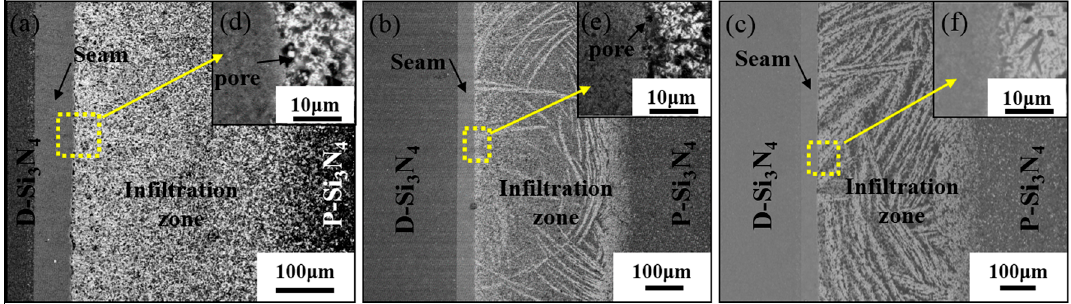
Figure 6. The microstructure of P-Si 3 N 4 /Y-SiAlON/D-Si 3 N 4 joints bonding at ( a , d ) 1550 °C, ( b , e ) 1600 °C, and ( c , f ) 1650 °C for 30 min.